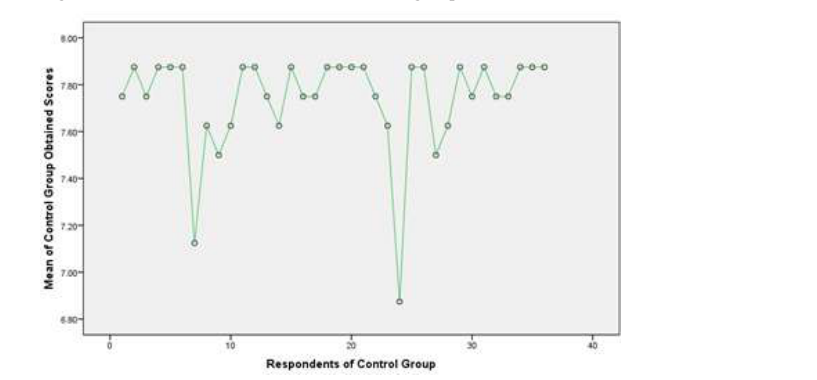
Figure 1 represents respondents of Control Group on X axis and mean of obtained scores of